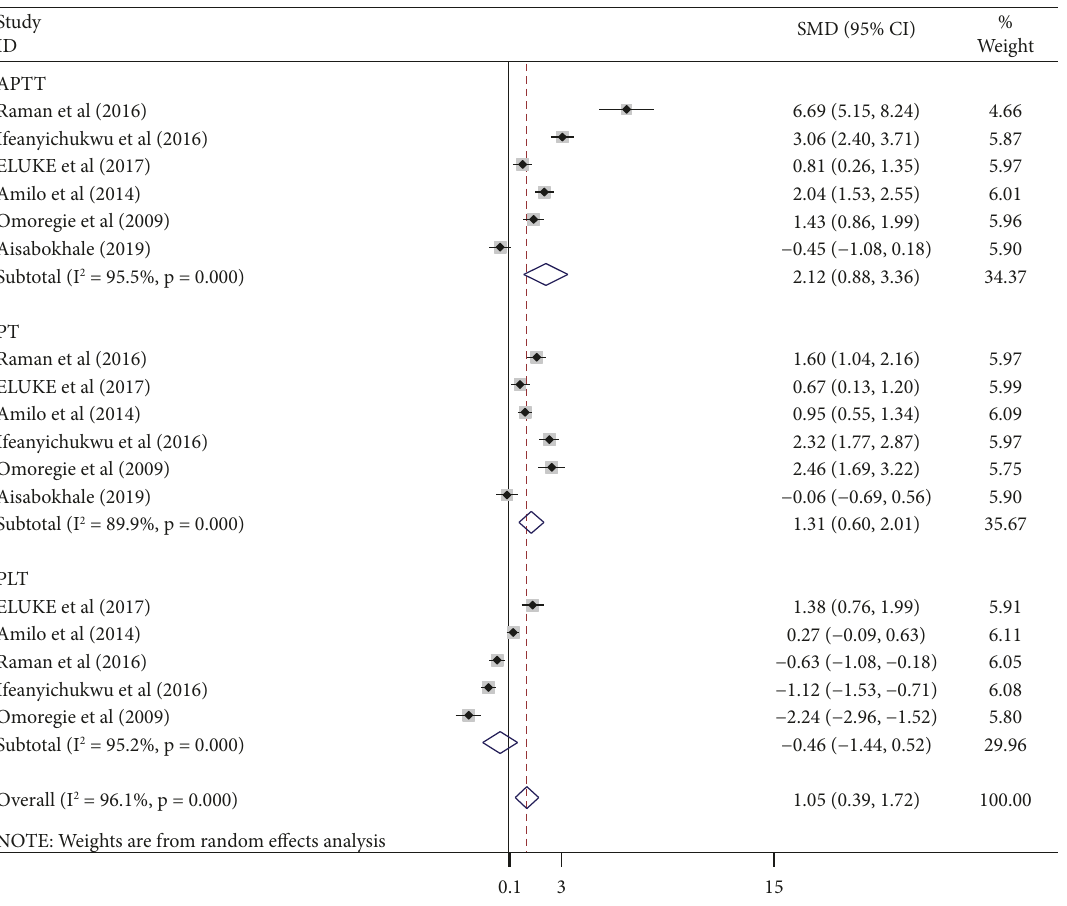
Figure 3: Forest plot showing the comparison of the APTT, PT, and PLT values between HAART-naive HIV-infected patients and seronegative